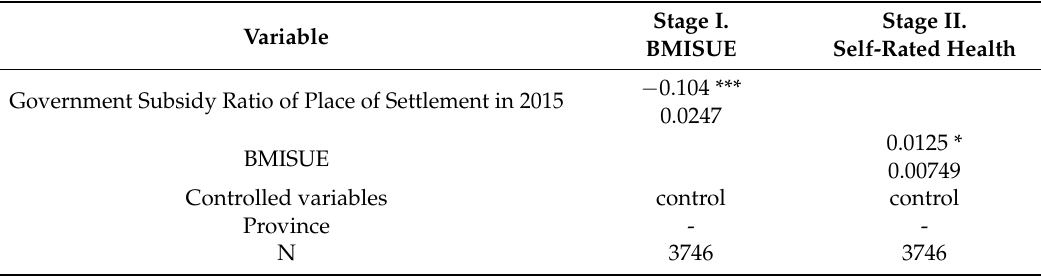
Table 5. IV Regression of health insurance and the health of the senior floating